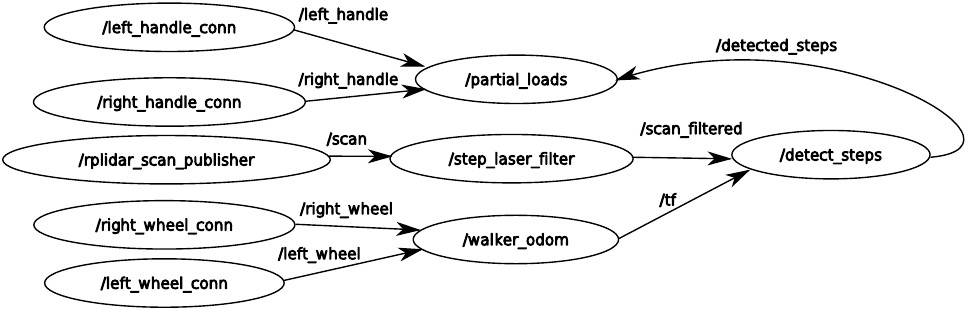
Figure 6. Main ROS2 nodes and